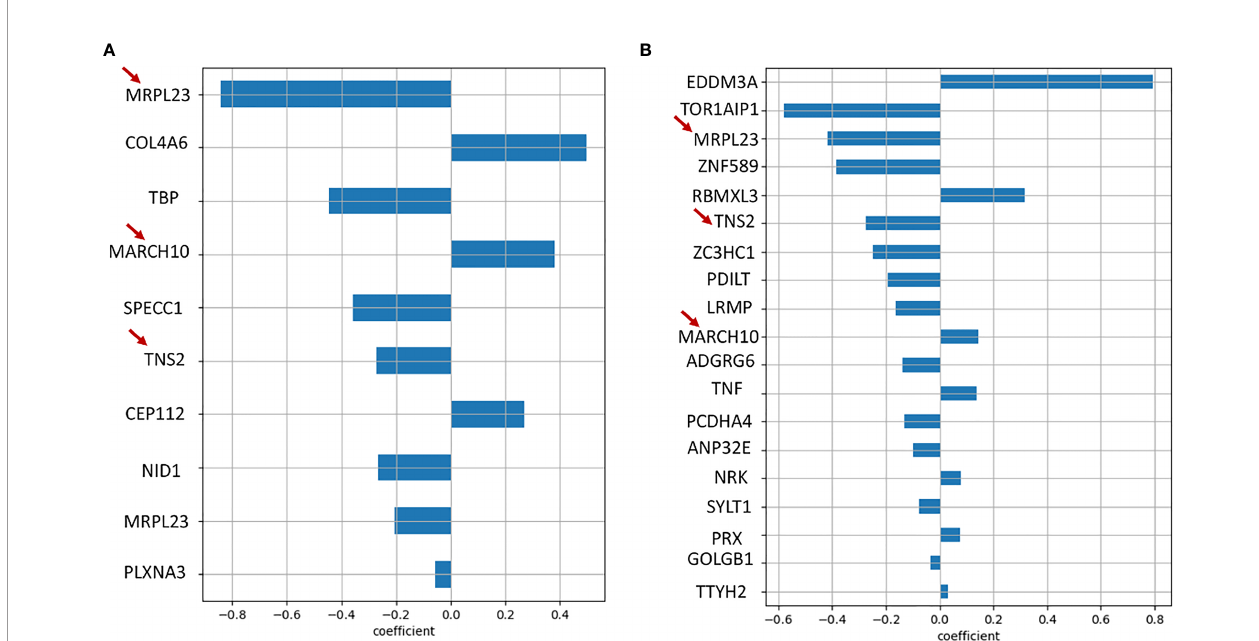
FIGURE 7 | (A) Bar graph showing genes obtained as signi fi cant prognostic markers from Lasso regression algorithm of the initial 36 alive/dead genes. (B) Bar graph showing genes obtained as signi fi cant prognostic markers from Lasso regression algorithm of all genes with missense mutations, run using 100 random alpha values and 10000 iterations. It is interesting to note that MRPL23, TNS2 and MARCH10, marked with red arrows, are common to both the